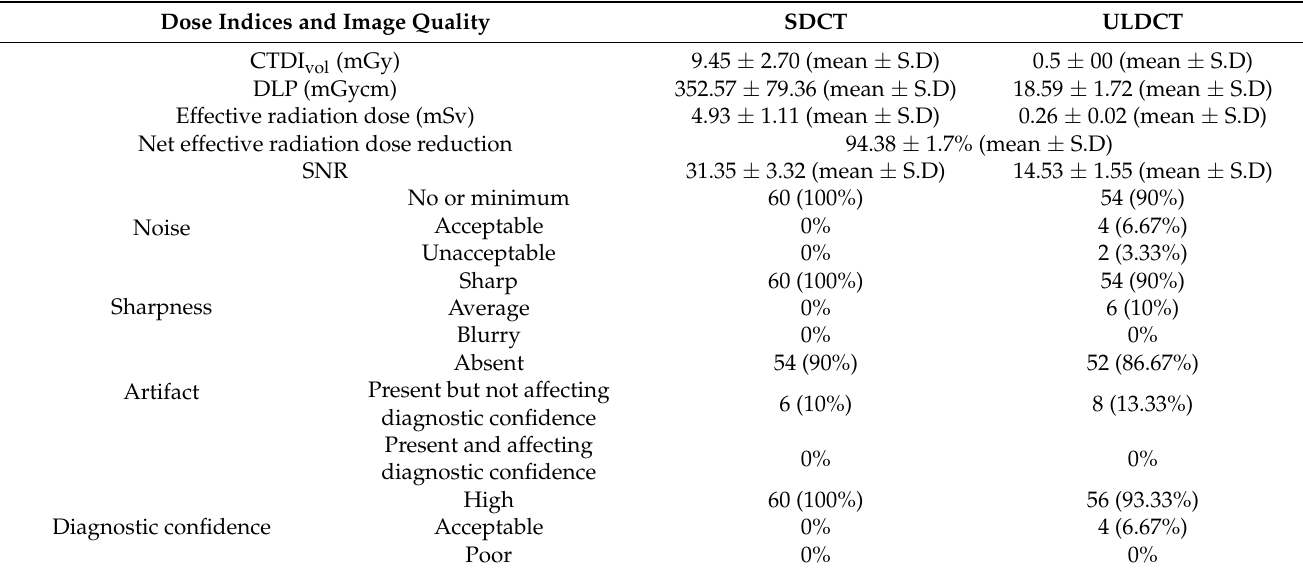
Table 3. Comparison of dose indices and image quality between SDCT and